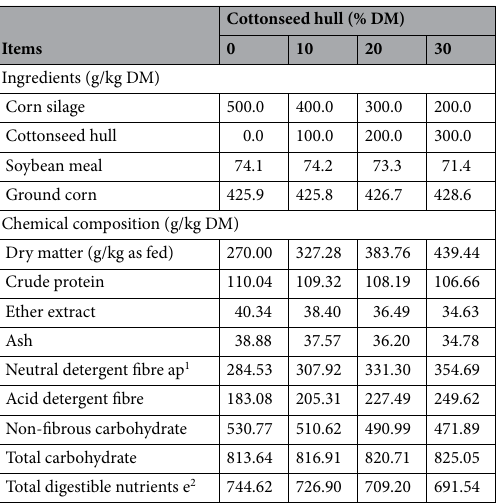
Table 6. Ingredient proportions and chemical composition of the experimental diets containing cottonseed hull levels. Mineral mixture provided ad libitum—Guaranteed levels (g/kg): 17,7 calcium, 8 phosphorus, 0,4 sodium, 2 sulphur, 5,5 copper, 80 iodine, 12 manganese, 0,15 selenium, 30 zinc and maximum 8 fluoride. 1 Corrected for ash and protein. 2